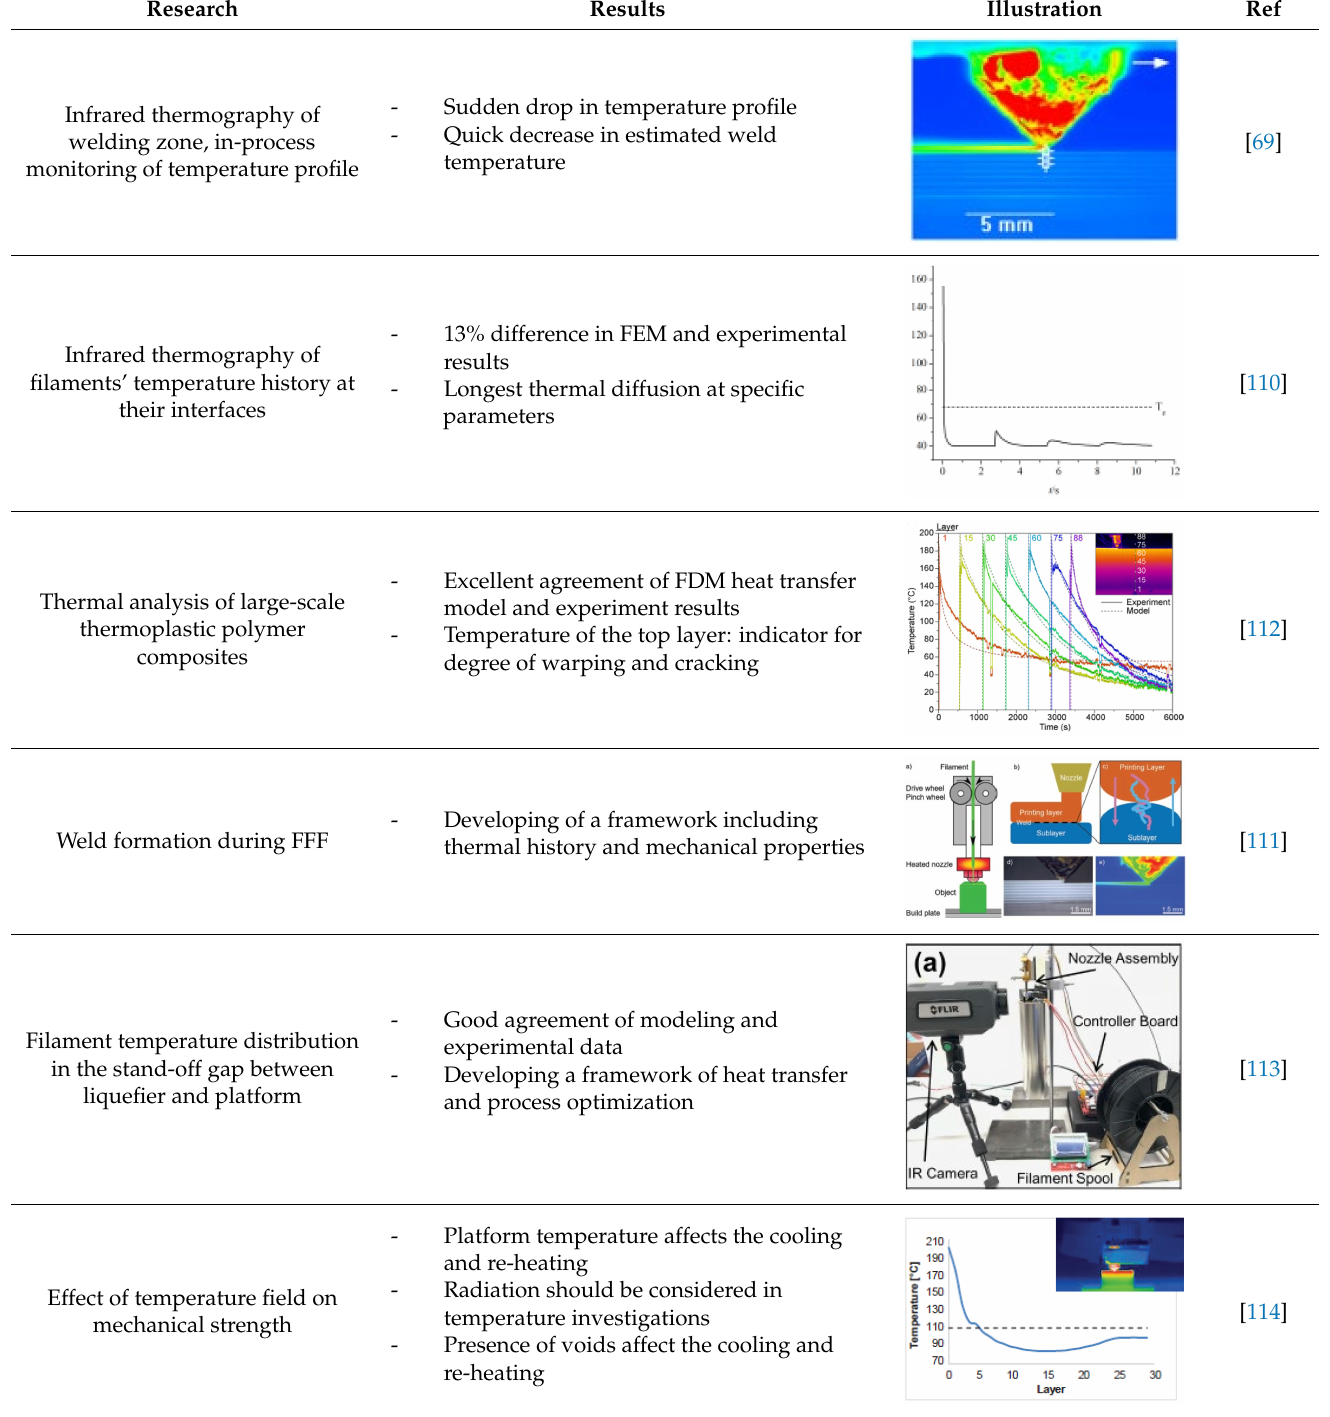
Table 2. Summary of in-process monitoring of temperature profile using IR camera.